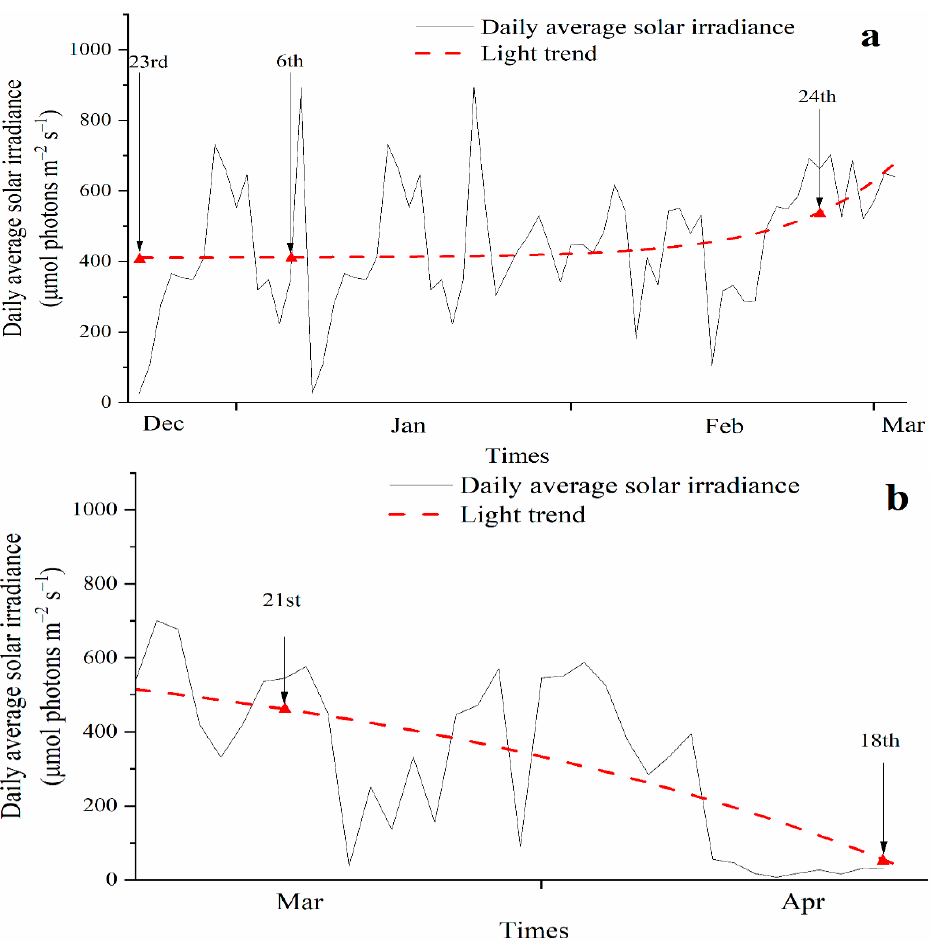
Figure 1. Changes in light intensity during N. yezoensis cultivation. ( a ) Haizhou Bay from mid-December to the end of February; ( b ) comparative experiment in Jimo. The intensity values were obtained from the average records collected in the daytime. The dashed line represents the trend line obtained by two polynomial curve fitting methods. The points marked in the figure are the sampling